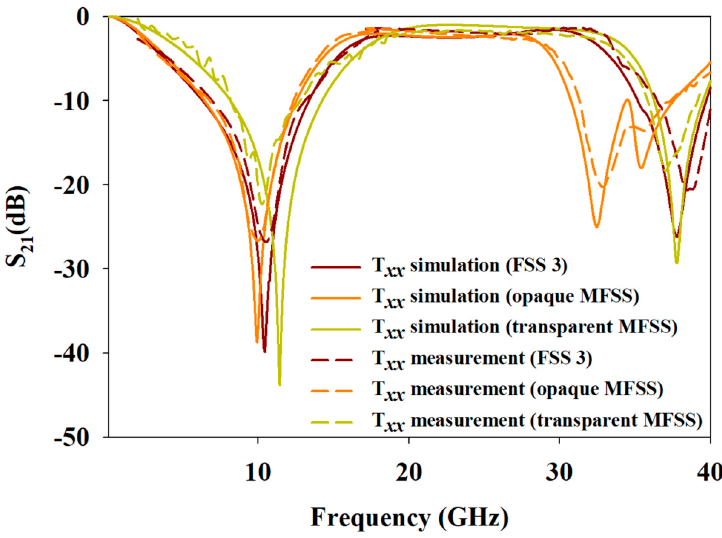
Figure 15. Experimental T xx versus simulation T xx of FSS 3, opaque MFSS, and transparent MFSS.